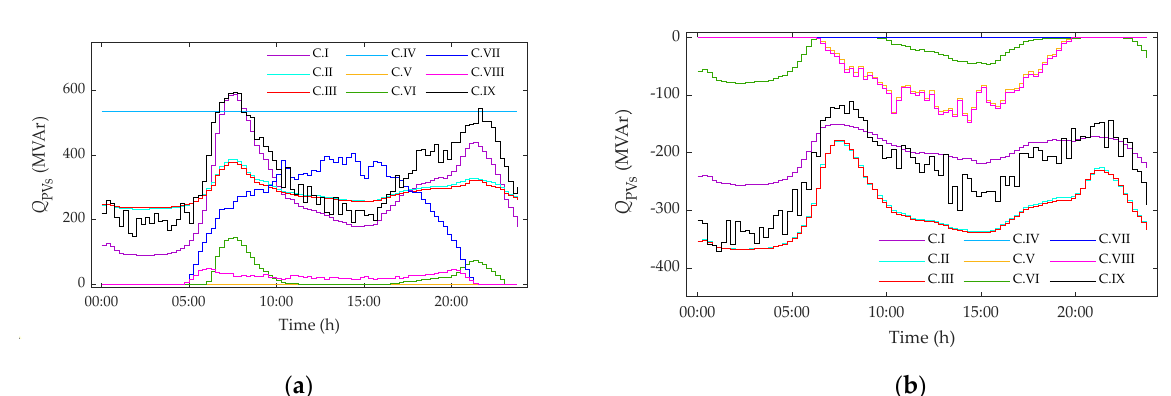
Figure 5. Total reactive power supplied by solar PVs every 15 min for the nine cases of reactive power control: ( a ) injection and ( b ) absorption.